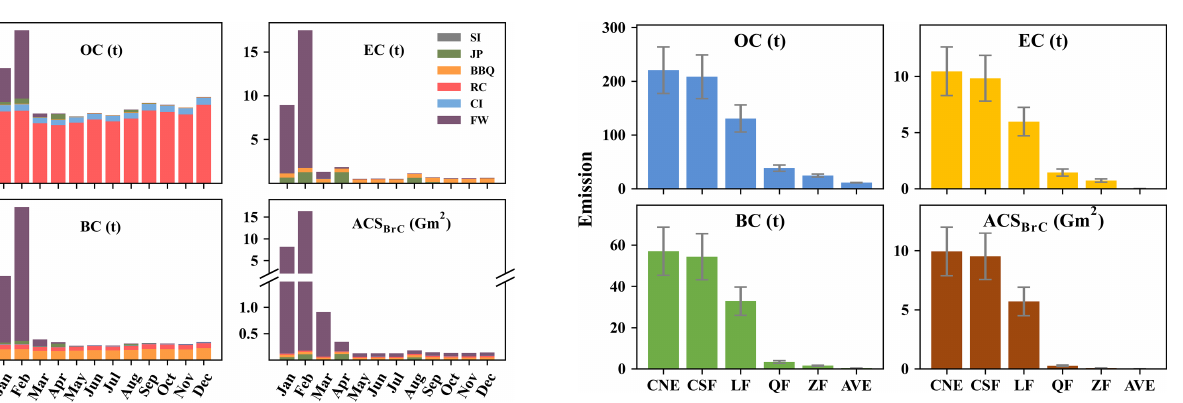
Figure 6. Averaged monthly CA emissions from the FMSs in China for the period from 2000 to 2018.